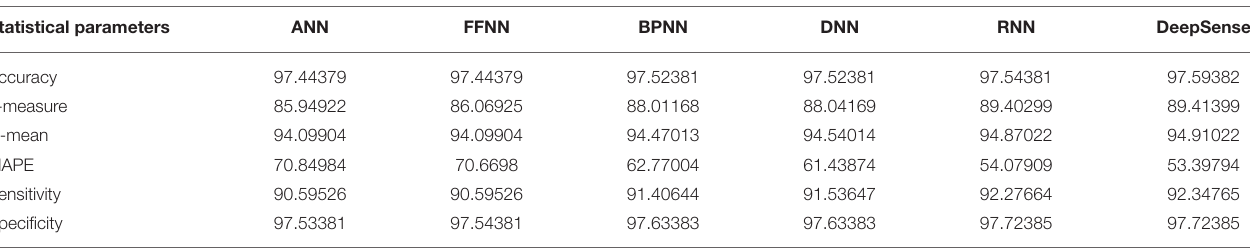
TABLE 9 | Results of statistical parameters for CORD-19 with 90% training data on 1,000 images. Statistical